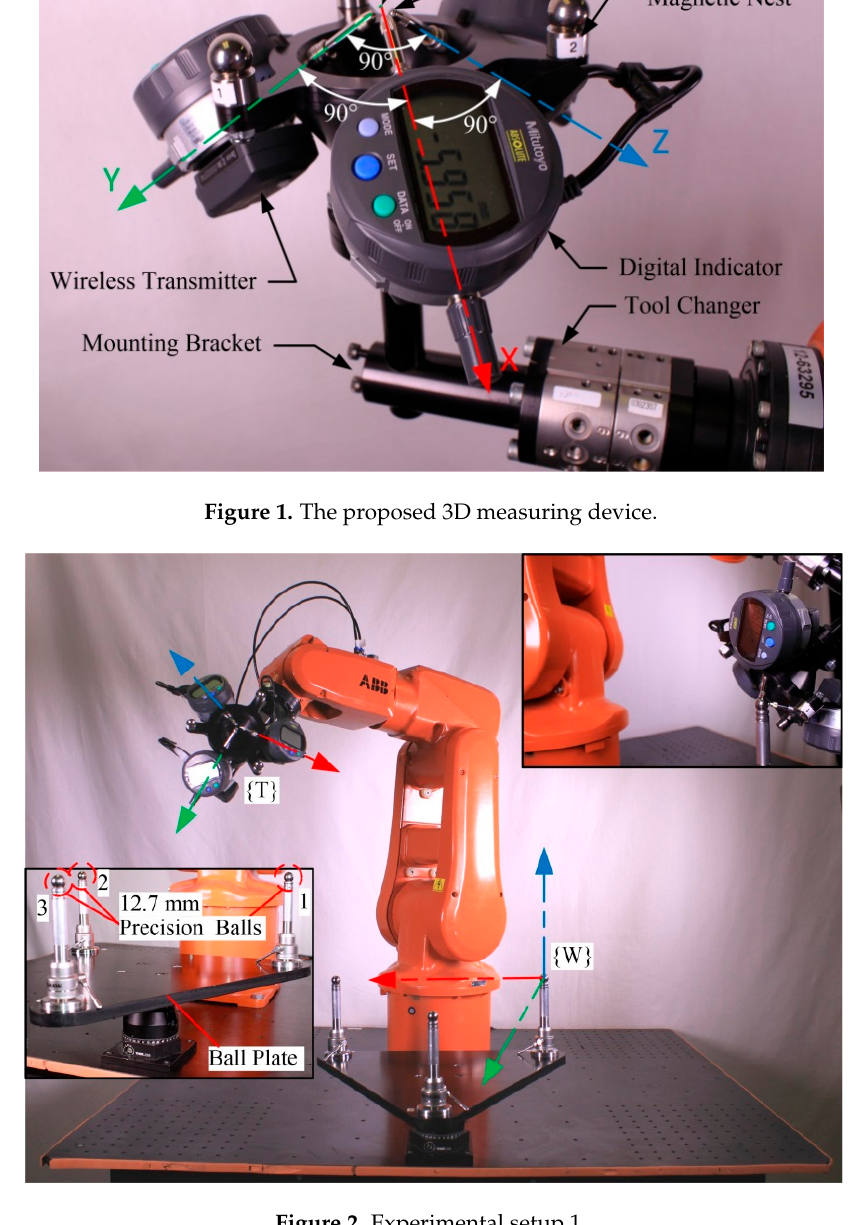
Figure 2. Experimental setup 1.